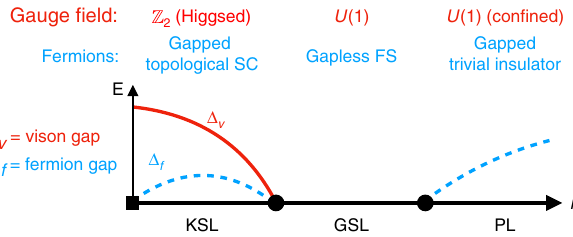
KSL GSL Fig. 7 Schematic phase diagram from the perspective of fermionic partons. The behavior of the fermions and associated gauge fi eld indicated for the KSL, GSL, and PL phases. The fl ux (vison) gap Δ v and the fermion gap Δ f is also shown